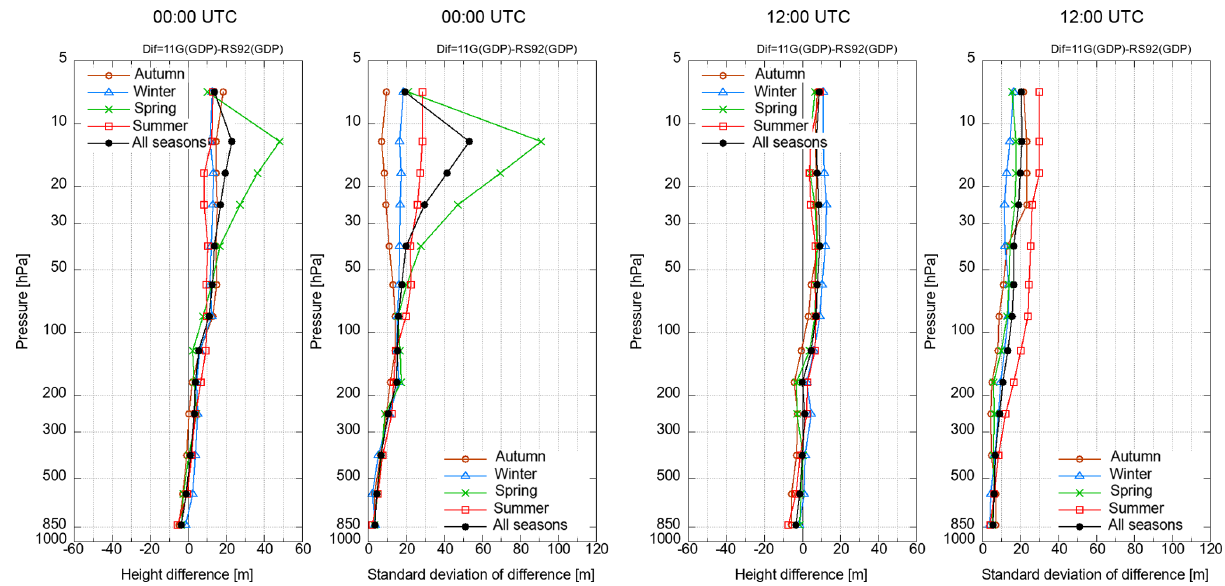
Figure 15. As per Fig. 10, but for geopotential